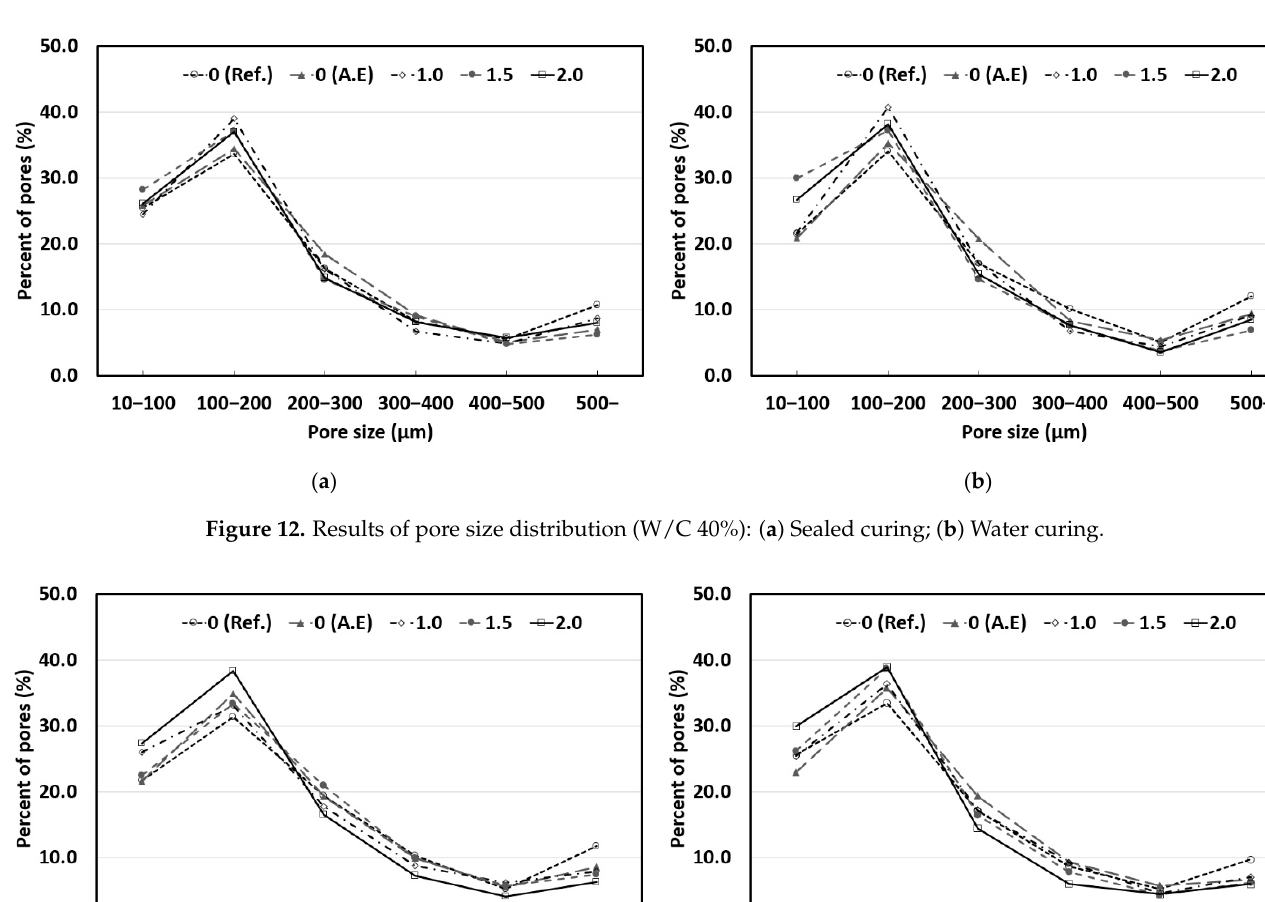
Table 7. Pore distribution according to pore size (300 μ m).